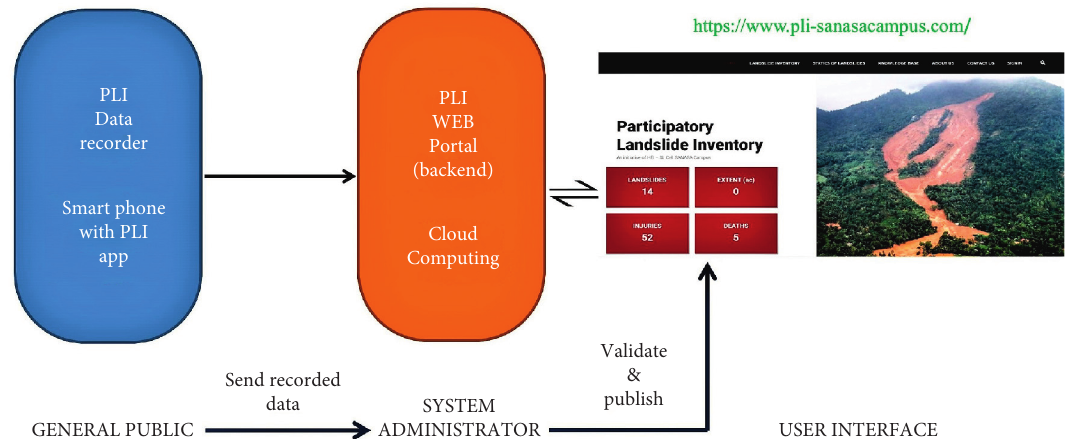
Figure 2: Simplified conceptual model of the participatory landslide inventory (PLI).